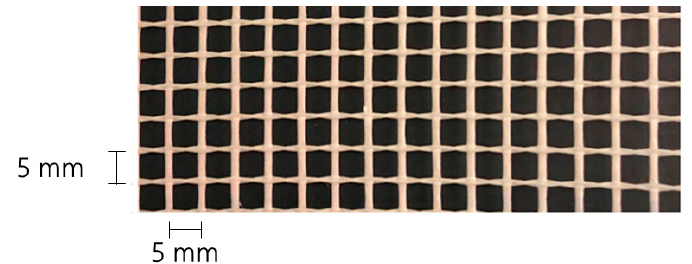
Figure 2. An alkali-resistant (AR) glass textile with a mesh size of 6 mm used.